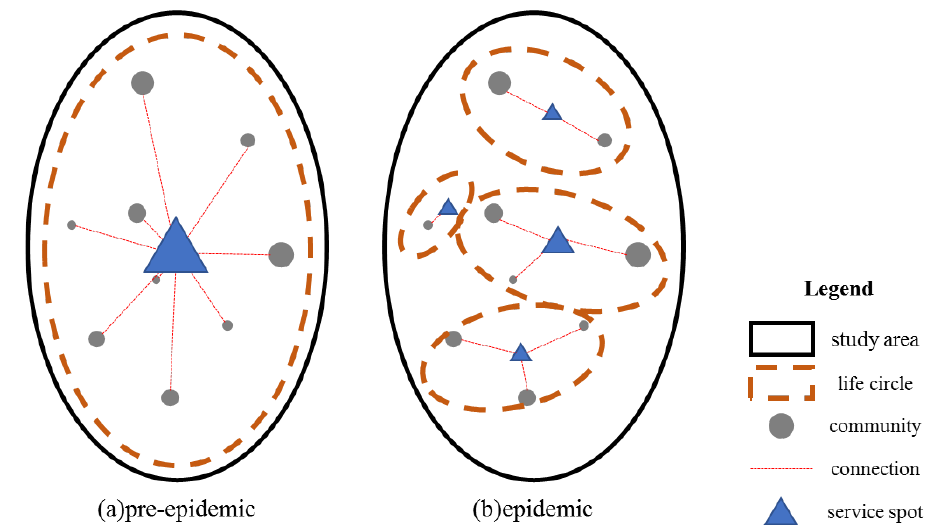
Figure 7. Living-circle modes of the pre-epidemic ( a ) and epidemic ( b ) periods.